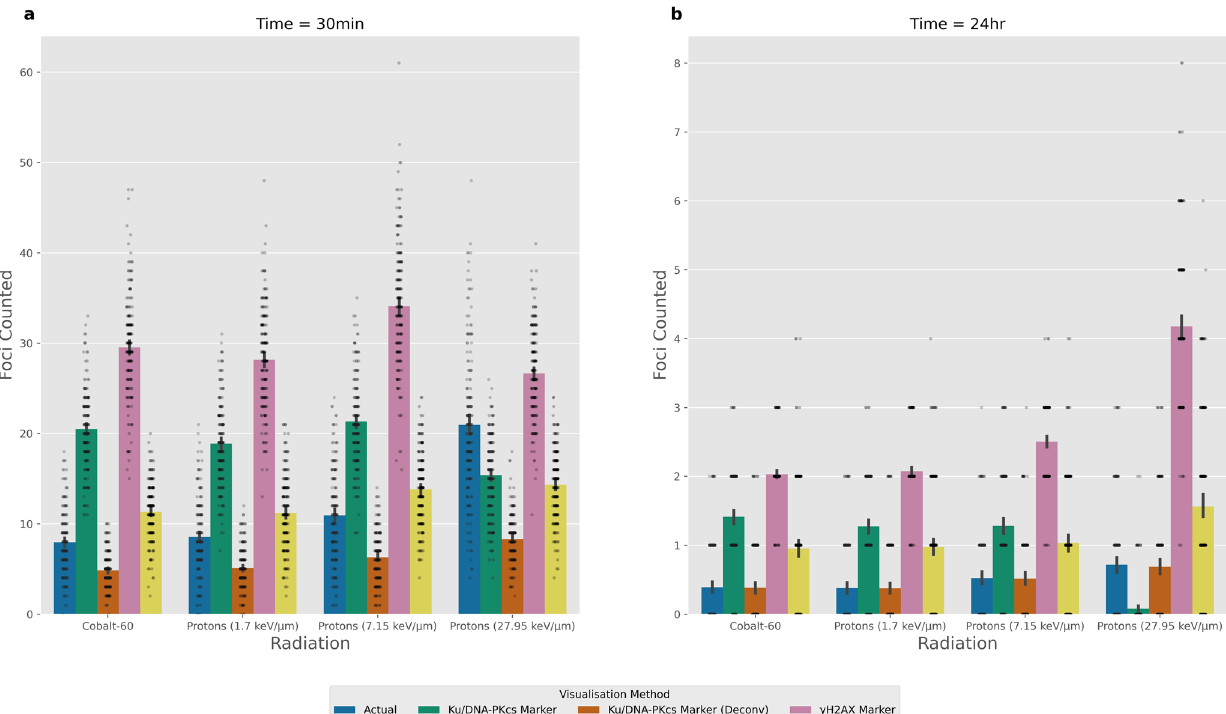
Fig. 6 Comparison of visualisation methods including deconvolution. This compares the number of foci detected for the four radiation types delivering 1 Gy at two-time points. Where a and b is 30 min and 24 h post-irradiation respectively. The actual value is given by the blue bar which is the known simulated number of DSBs within the evaluated z-slice. Whereas, the other bars represent the foci detected from the corresponding visualisation method. Marker visualisation which has been deconvolved represent perfect deconvolution as the image is created before the microscope PSF is applied. Each bar is the averaged result of 200 independent samples and the error bars are the 95% con fi dence intervals. All data are for an emulated Airyscan ×63